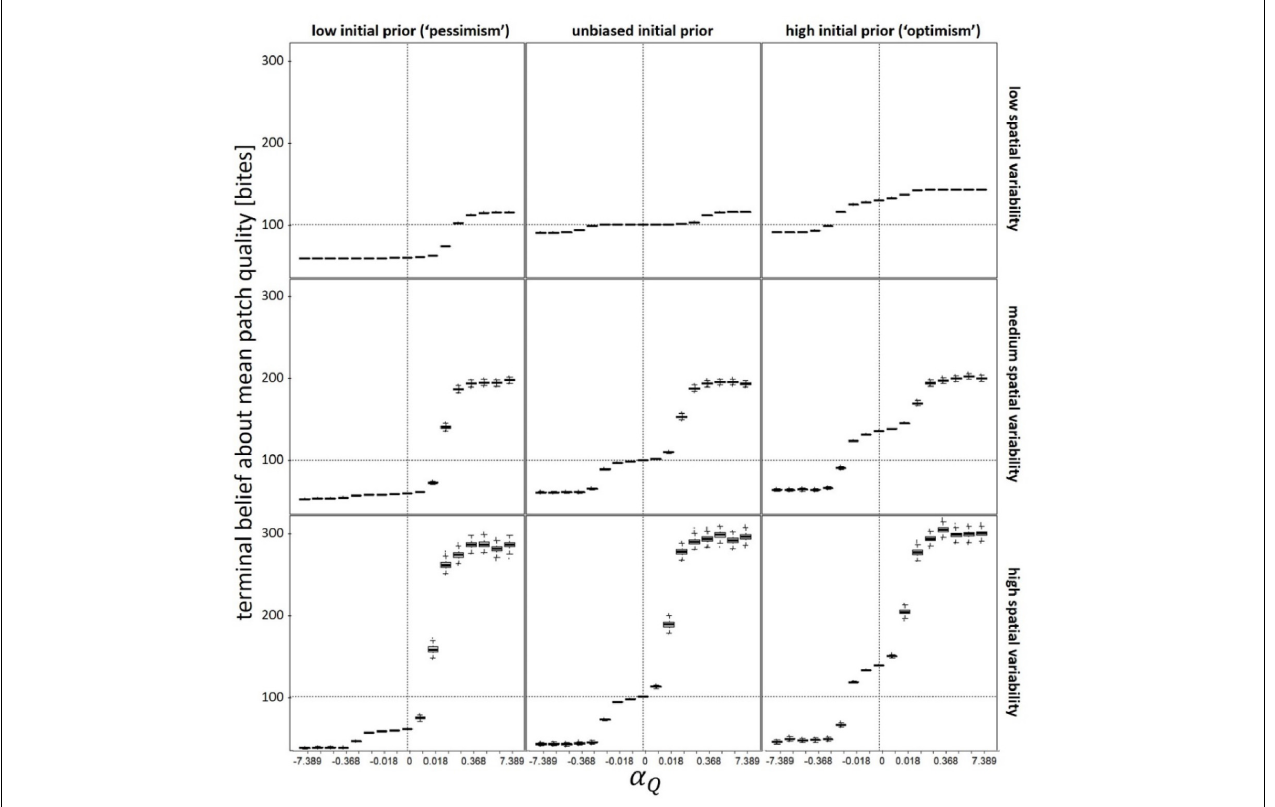
FIGURE 1 | Terminal belief (at the end of the simulation) about the mean patch quality as function of valence-dependence for patch quality (positive values of α Q correspond to valence-dependent optimism whereas negative values correspond to valence-dependent pessimism). Vertical dashed lines denote unbiased learning ( α Q = 0), whereas horizontal dashed lines denote an unbiased terminal belief (cid:0) Q ( end ) = b Q (cid:1) . Different panels refer to different scenarios: low ( Q ( t = 0) = 50), unbiased ( Q ( t = 0) = 100), and high ( Q ( t = 0) = 150) initial prior belief (columns), and low ( CV ( Q ) = 0.1), medium ( CV ( Q ) = 0.5), and high ( CV ( Q ) = 1) spatial variability (rows). In each scenario, α T was kept constant at its optimal (fitness maximizing) value. T ( t = 0) = b T = 10; CV ( T ) = 0.5; P travel = t max − 1 other parameters and variables were as detailed in Table 1